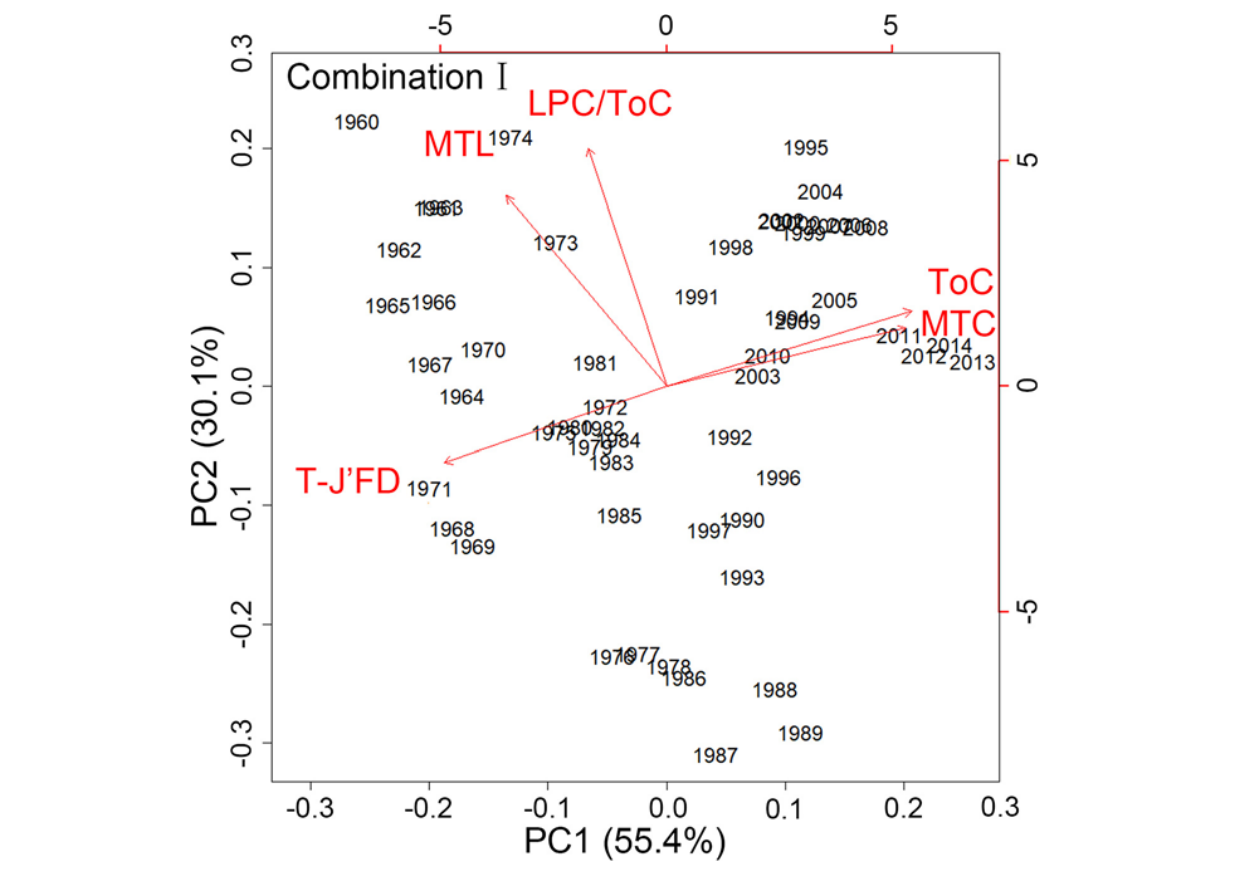
FIGURE 6 | Results of the standardized principal component analysis (PCA) using the final indicator suite (consist of ToC, LPC/ToC, MTL, MTC, T-J (cid:48) FD). Red lines describing the indicator loadings on the first and second principal components